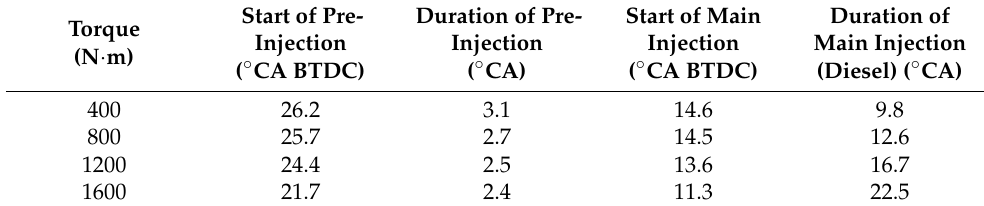
Table 6. Injection strategy at 1900 r/min.